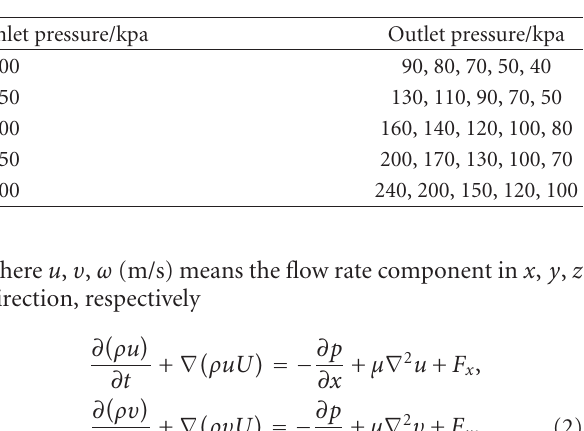
Table 2: Outlet pressures under the di ff erent inlet pressures of Venturi